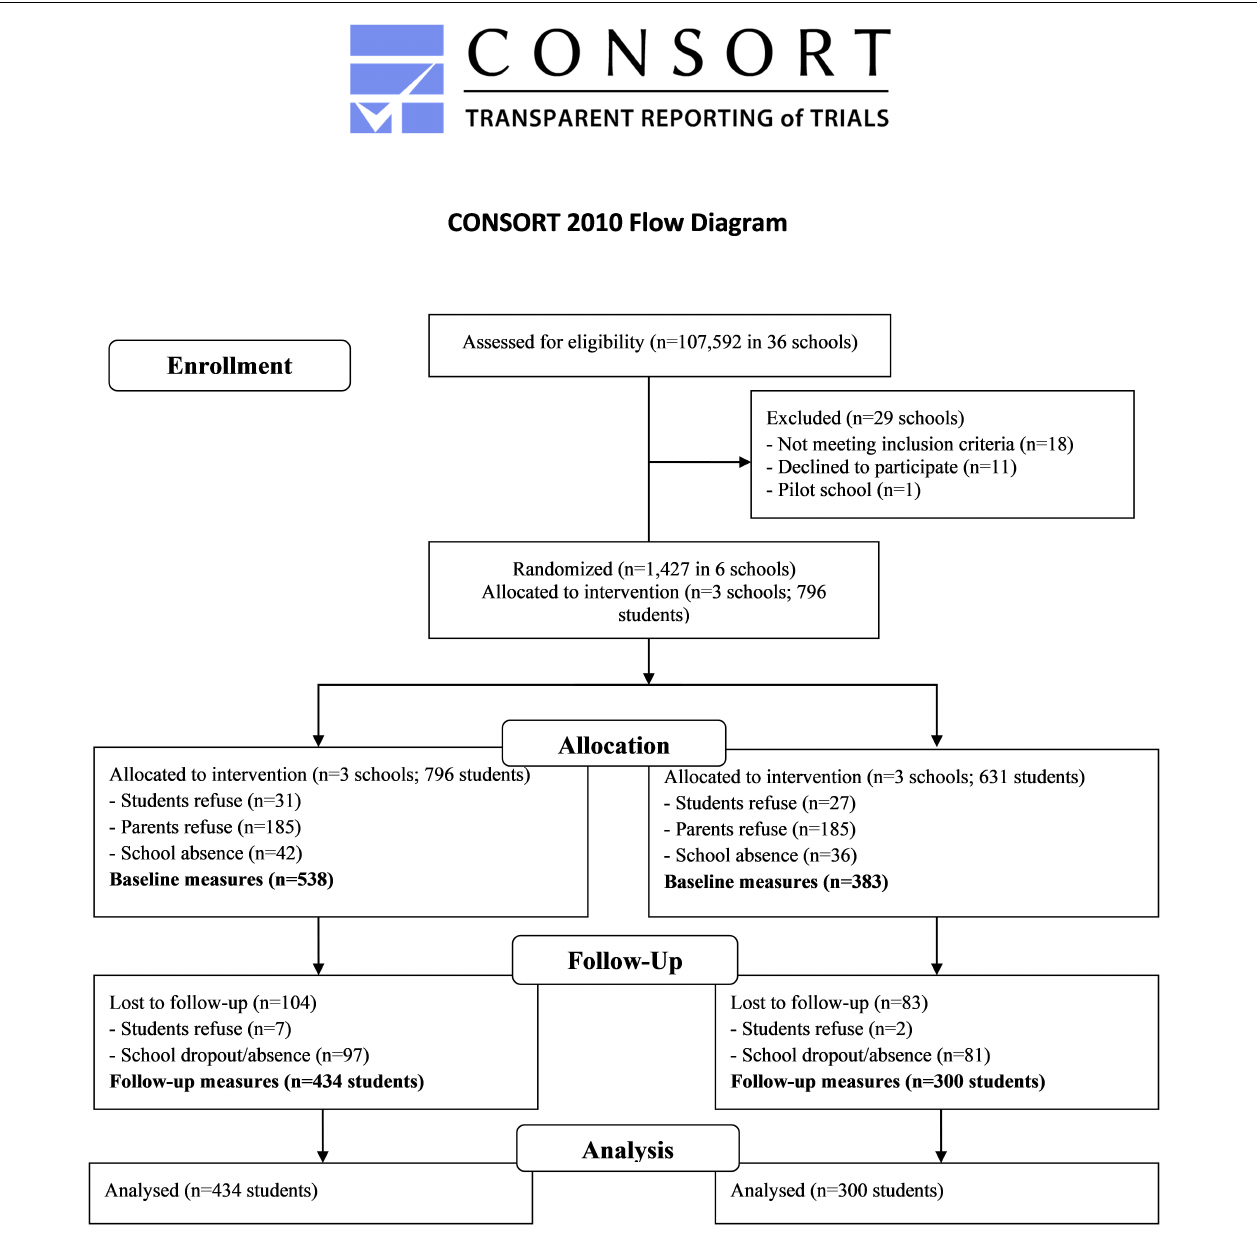
FIGURE 1 | CONSORT flow diagram of recruitment, randomization, and participation of schools and adolescents in the Movimente